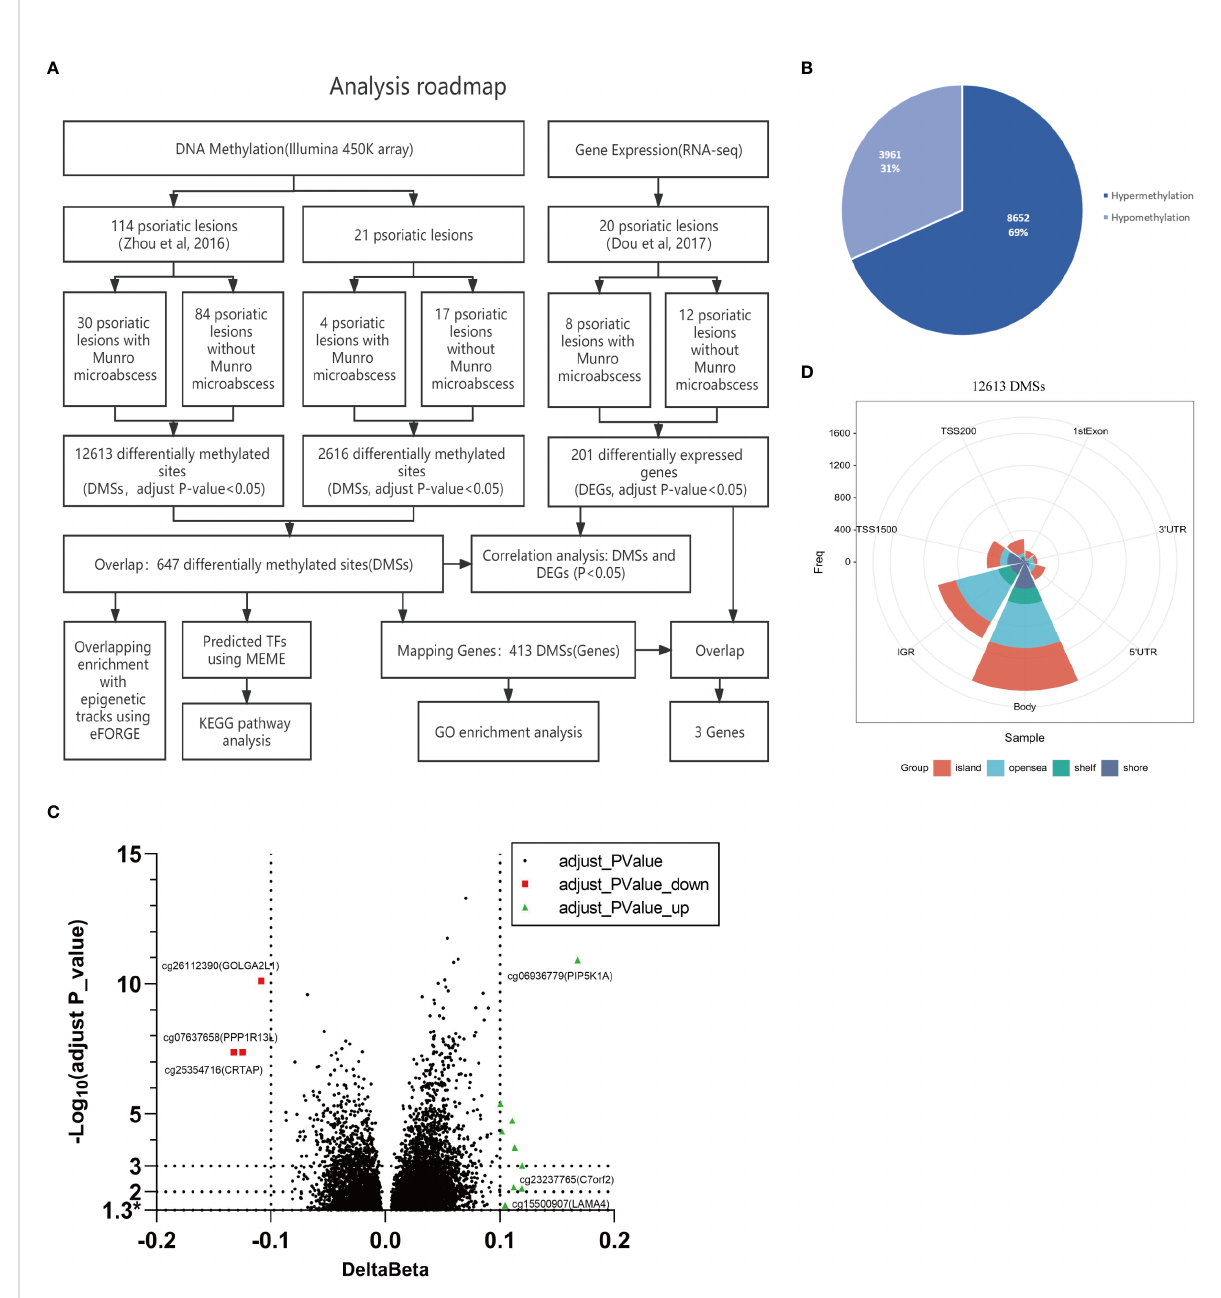
FIGURE 1 Idea map and differential methylation characteristics of 114 samples with and without Munro ’ s microabscess. (A) The whole analysis roadmap. (B) The number and proportion of hypermethylated and hypomethylated probes at 12,613 DMSs with or without Munro ’ s microabscess in 114 samples. (C) Volcano plot using -Log 10 (adjust P_value) and delta Beta at 12,613 DMSs.* stands adjust P_valve < 0.05. (D) Distribution of 12613 DMSs in CpG regions and on the